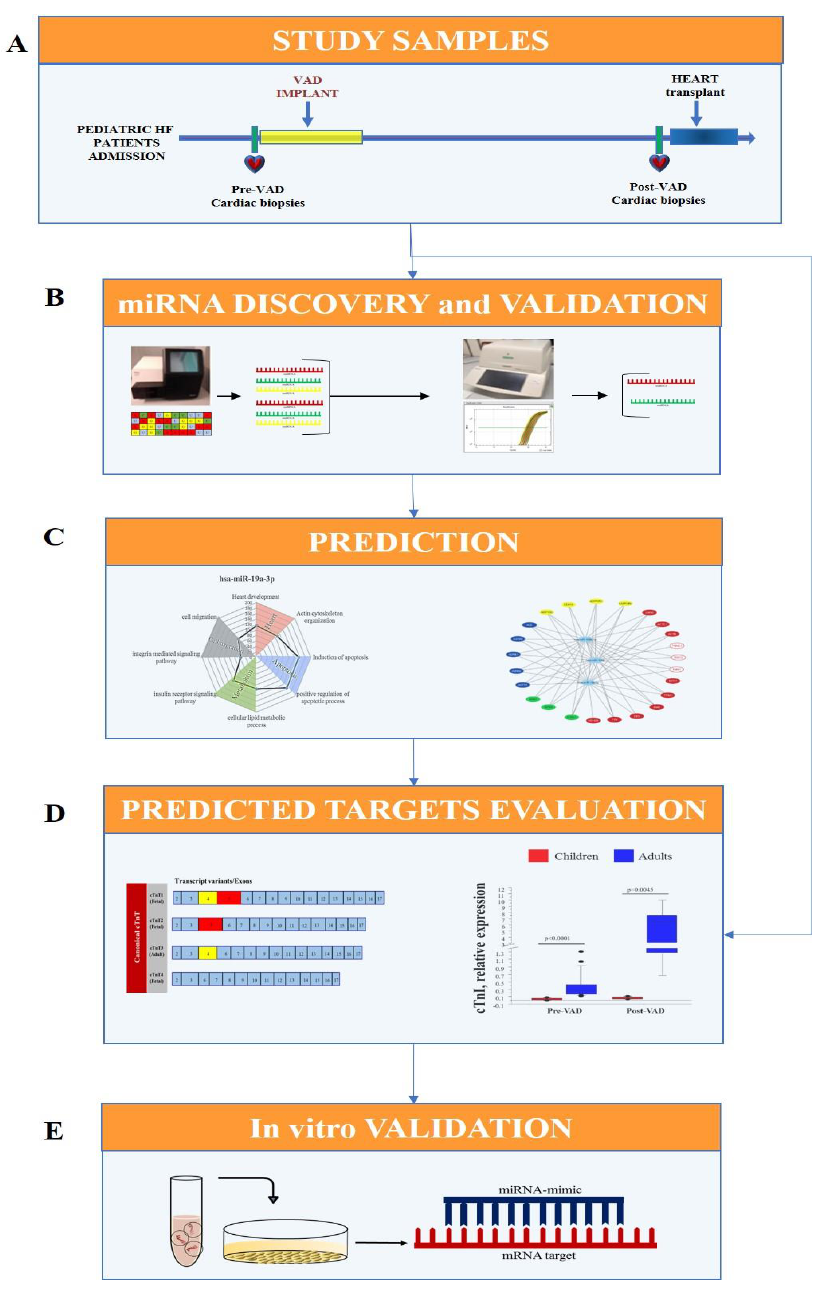
Figure 1. Experimental design. ( A ) Cardiac samples were collected from HF pediatric patients at the moment of VAD implant (pre-VAD) and at the moment of heart transplant after VAD support (post-VAD). Total RNA (miRNA and mRNA) was extracted from cardiac samples. ( B ) In order to identify the miRNAs modified by VAD support, cardiac miRNA profile at pre-VAD and post-VAD was evaluated by NGS and real-time PCR was performed to validate sequencing results. ( C ) The in-silico analysis was employed to predict the putative targets of validated miRNAs. ( D ) The cardiac expression of miRNAs predicted targets was evaluated in HF children at pre-VAD and post-VAD and compared with a group of adults with HF. ( E ) An in vitro transfection study in HL-1 cell line was performed to verify the regulatory role of selected miRNAs on predicted targets.